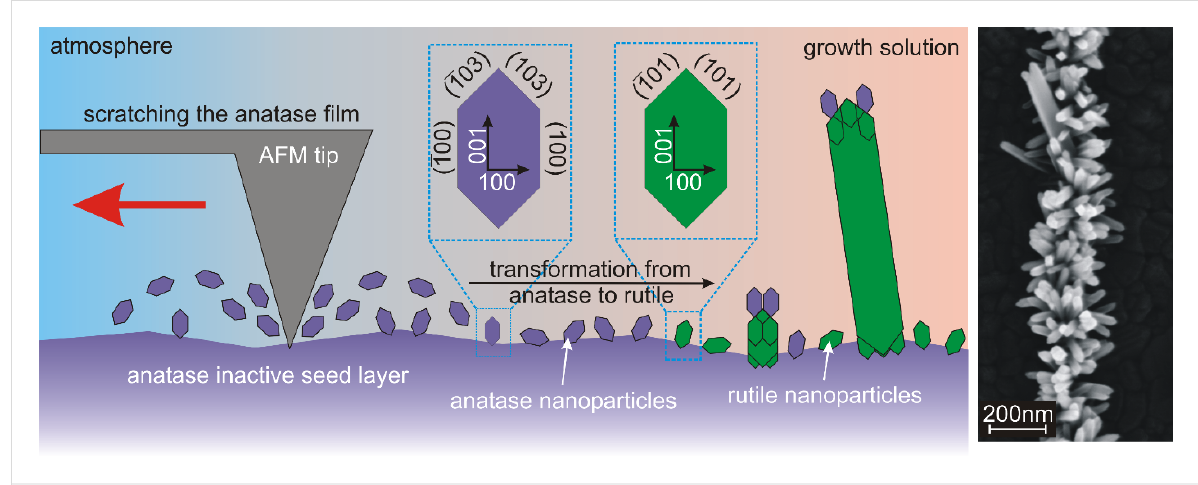
Figure 1: Schematic drawing of activating inactive anatase TiO 2 films: Scratching with an AFM tip causes the formation of anatase nanoparticles. In the growth solution, these anatase particles are transformed into rutile particles and promote the growth of rutile TiO 2 nanorods as described by Li et al. [37]. The SEM image displays the resulting row of nanorods obtained with the method presented in this